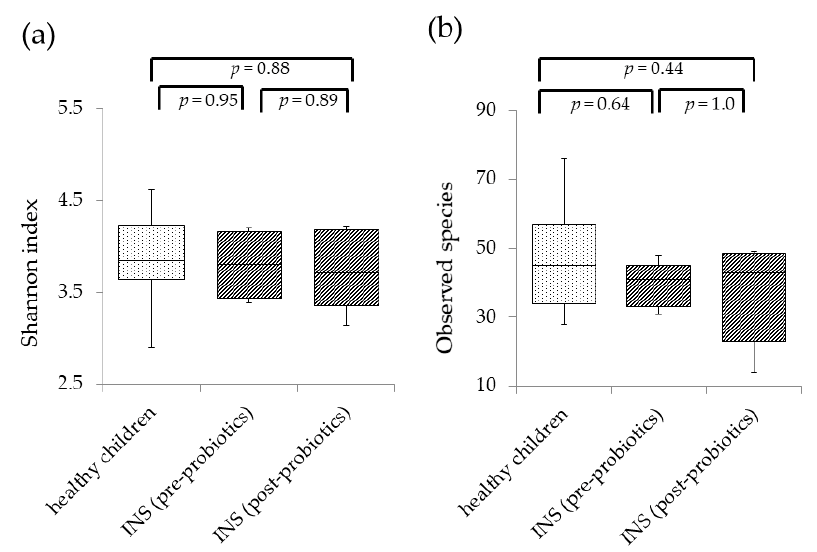
Figure 1. Analysis of the diversity of gut microbiota in healthy children and children with idiopathic nephrotic syndrome (INS) before and after Clostridium butyricum MIYAIRI administration. A whisker-plot diagram of Shannon index ( a ) and number of observed species ( b ) is shown for each group. Shannon index and the number of observed species were calculated in healthy children as well as children with INS before and after probiotic treatment. There were no significant differences among the three groups in either Shannon index or number of observed species. The central horizontal line in the box represents the median value, while the bottom and top edges of the box represent the first and third quartiles, respectively. Central vertical lines extend from the box to the 90th and 10th percentiles.